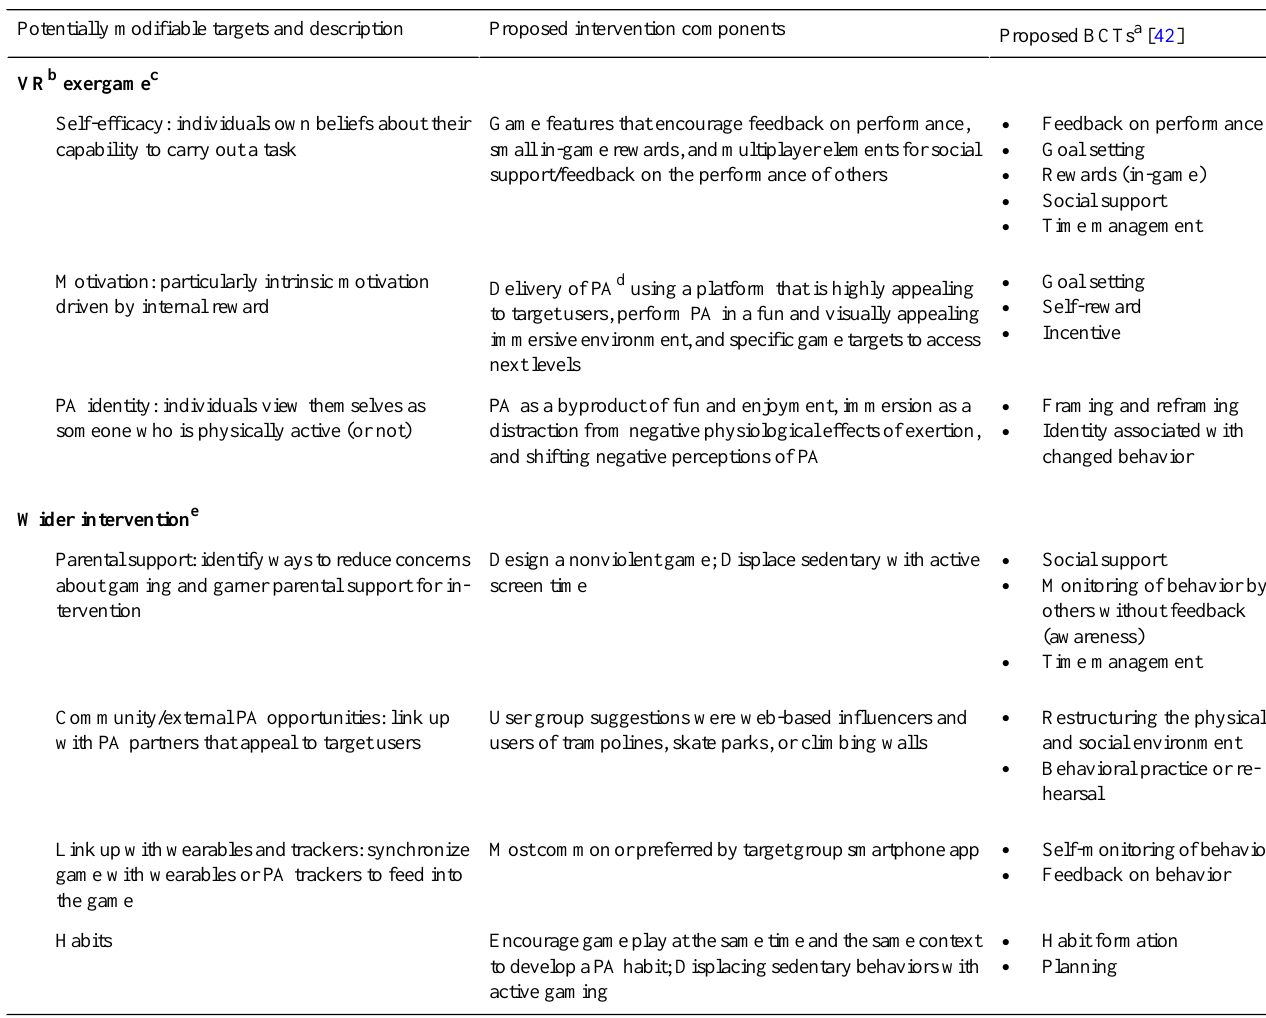
Table 2. Behavioral determinants of adolescent physical activity from literature reviews and hypothesized method of inclusion in the intervention.